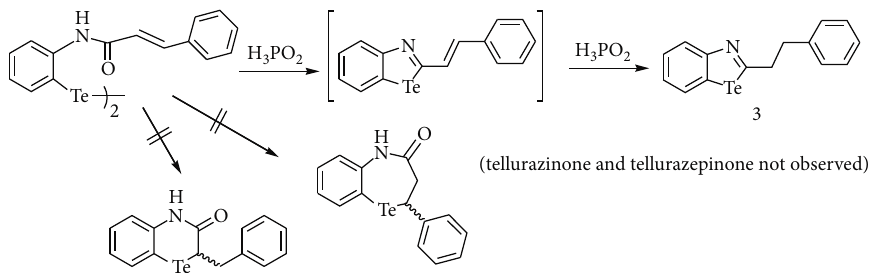
Figure 7: Reductive cyclization of (E,E)-2,2 ′ -[(1-oxo-3-phenyl-2-propenyl)aminophenyl] ditelluride.